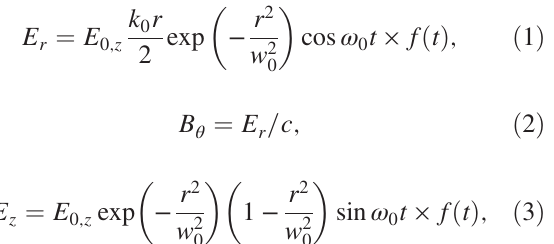
ffiffiffiffiffiffiffiffiffiffiffiffiffiffi p P ½ TW (cid:2) , both with linear and